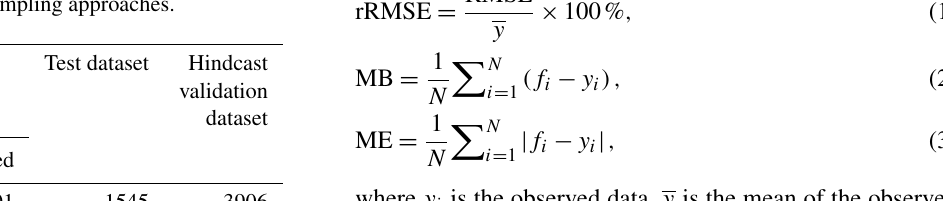
Table 3. The number of samples for training, test, and hindcast val- idation datasets. The adjusted sample size for training data was de- termined through the over-/subsampling